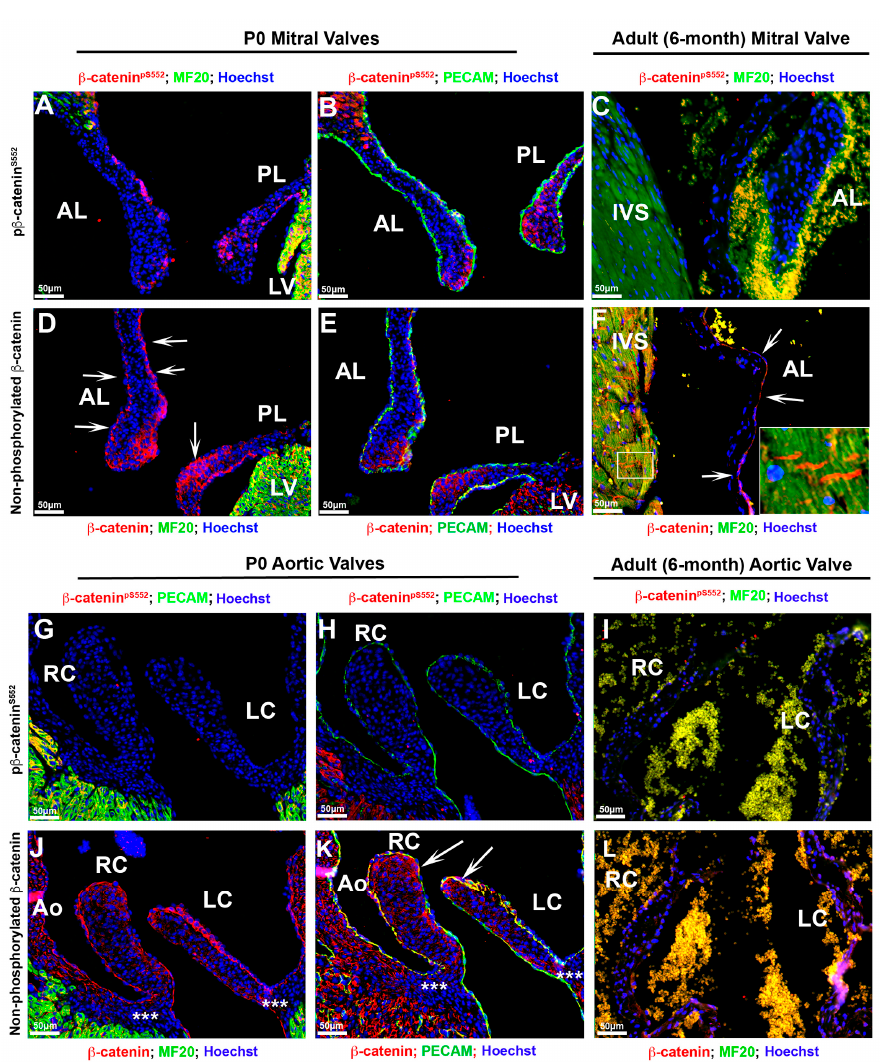
Figure 8. Postnatal cardiac β -catenin expression. ( A , B ) Both forms of β -catenin were stained on P0 and 6-month adult tissues. Activated form of β –catenin was only present within a subset of mitral valve interstitial cells confined to the tips at neonatal timepoints; however, the mitral valve endocardium is mostly devoid of positive nuclear staining. ( D , E ) Membrane staining for β -catenin was observed on mitral valve endocardium and co-labeled with Pecam (( D )—arrows—and ( E )). ( C , F ) In adult mice no detectable nuclear β -catenin was observed within the mitral leaflets and IVS myocardium ( C ), whereas the non-phosphorylated β -catenin isoform was present primarily along the valve endocardial lining of the atrialis (( F )—arrows) and within the intercalated discs of cardiomyocytes (( F )—boxed region). ( G , H ) Activated form of β -catenin was not detectable within the aortic valves at neonatal time point. ( J , K ) Membrane-bound β -catenin co-labeled with Pecam within the aortic valve endocardium as well as a subset of interstitial cells at the tips of the cups (( K )—arrows). Membrane bound β -catenin was not observed within the hinge regions of the aortic cups (asterisks in ( J )), but was found within the aortic wall ( J , K ). ( I , L ) Neither form of β -catenin was observed in the adult aortic valve leaflets. AL = anterior leaflet, PL = posterior leaflet, IVS = interventricular septum, LV = left ventricle, Ao = aorta, RC = right coronary cusp, LC = left coronary